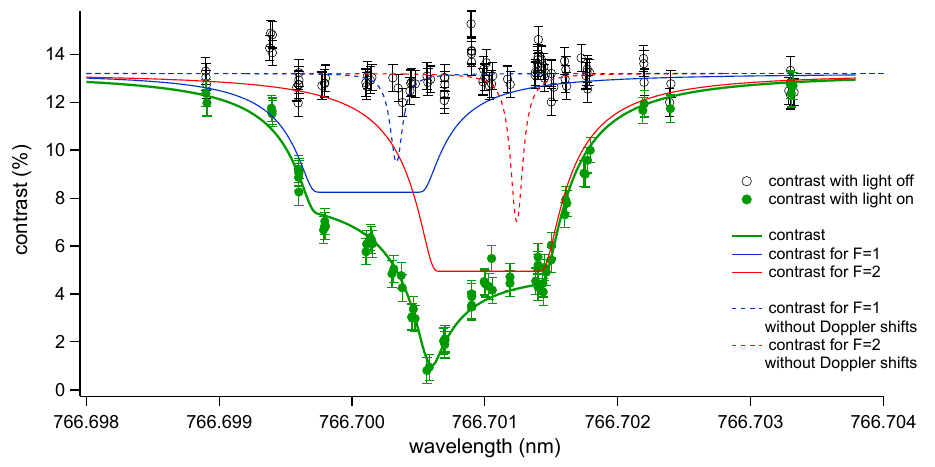
Figure 5. Contrast data spectrum (green points) and model (green line). The dashed red and blue lines show contrast spectra for each hyperfine ground state with no Doppler shift. The model has parameters Ω Rabi = 6.2 Γ , T = 3/ Γ , θ = 1.3 mrad, and δ = 28.3 mrad, which corresponds to a net Doppler shift of − 0.21 ± 0.05